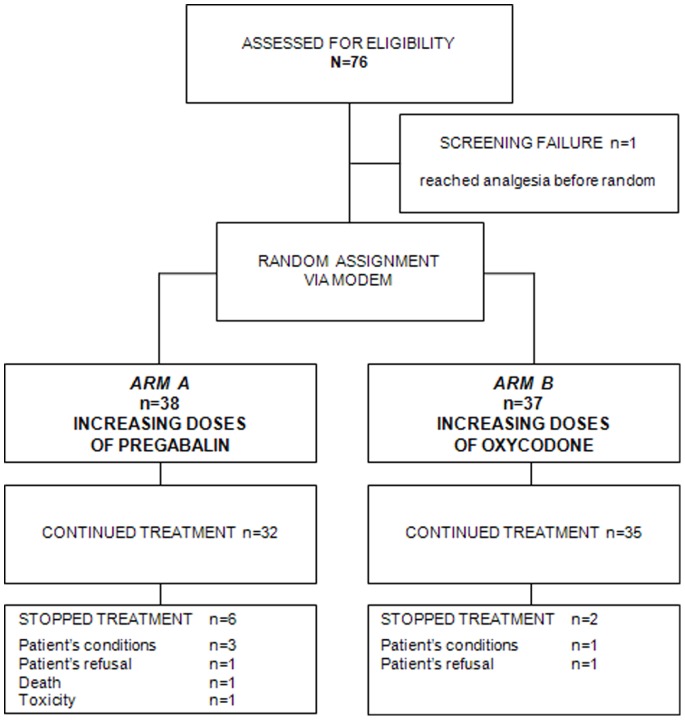
Patient CONSORT Diagram.